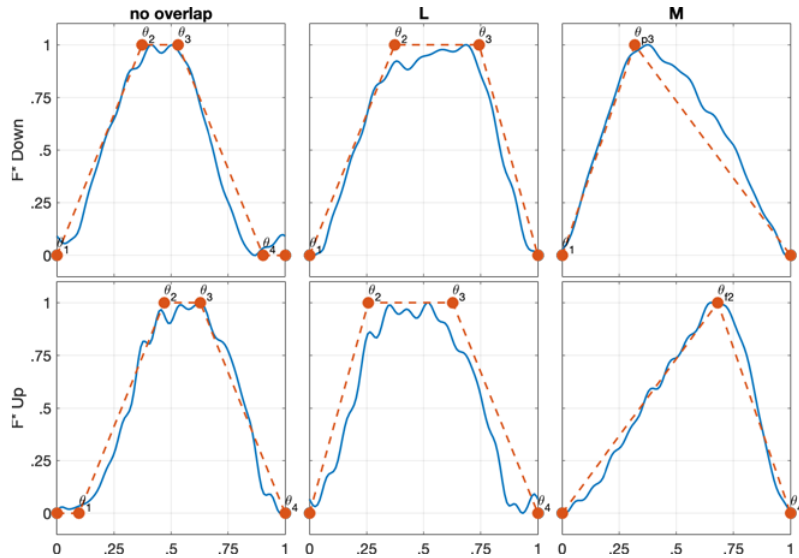
Figure 9. Type IIa normalized F shapes (tests 13 to 15 in down-milling; tests 16 to 18 in up-milling).